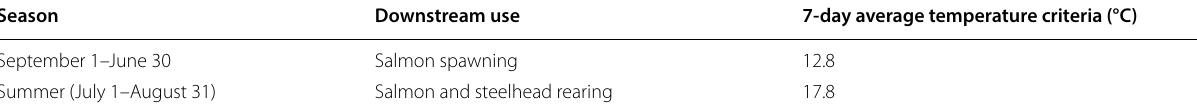
Table 1 Biologically based numeric criteria prescribed under TMDL for North Santiam Subbasin of Detroit dam Season Downstream use